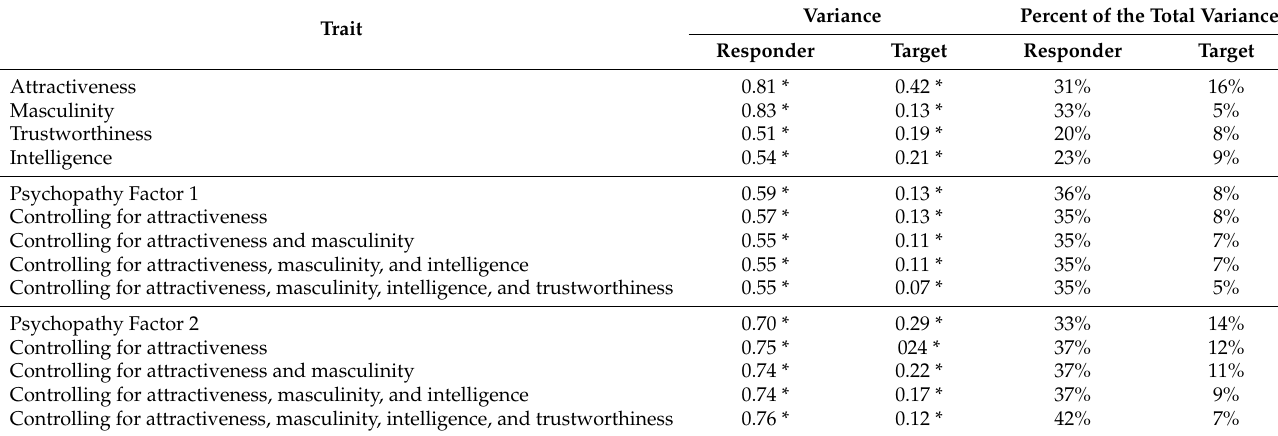
Table 1. Study 1: Social Relations Analysis with and without controlling for halo